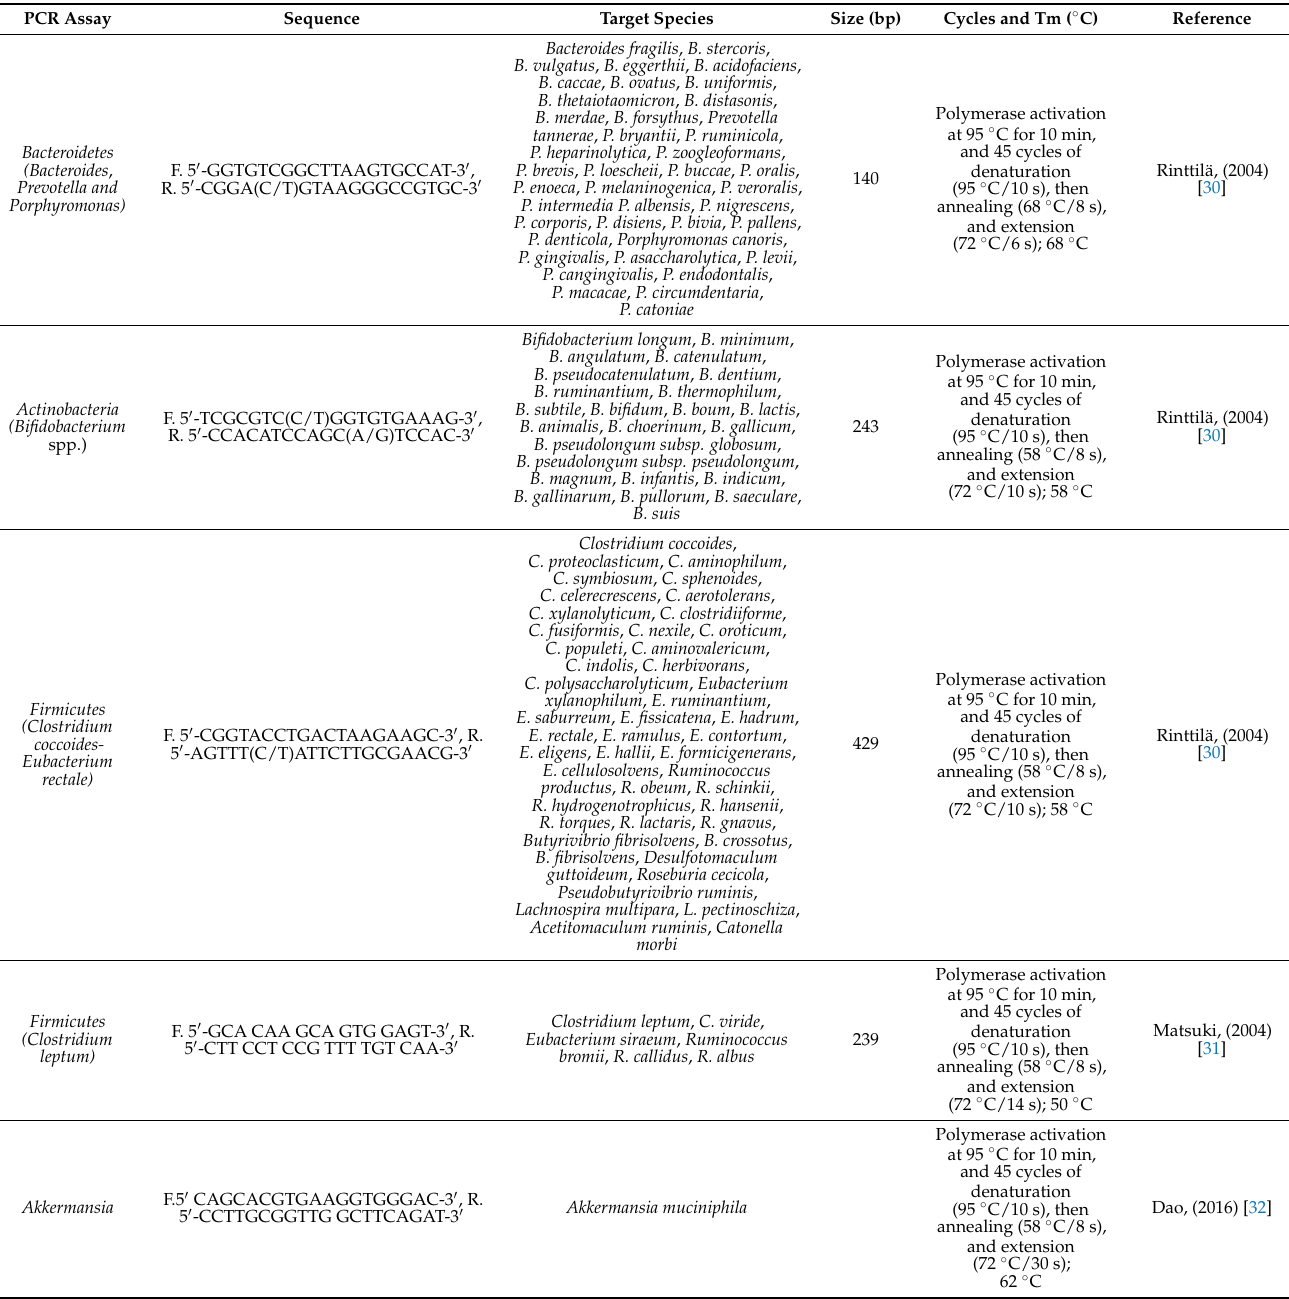
Table 1. Sequences of primers for real-time